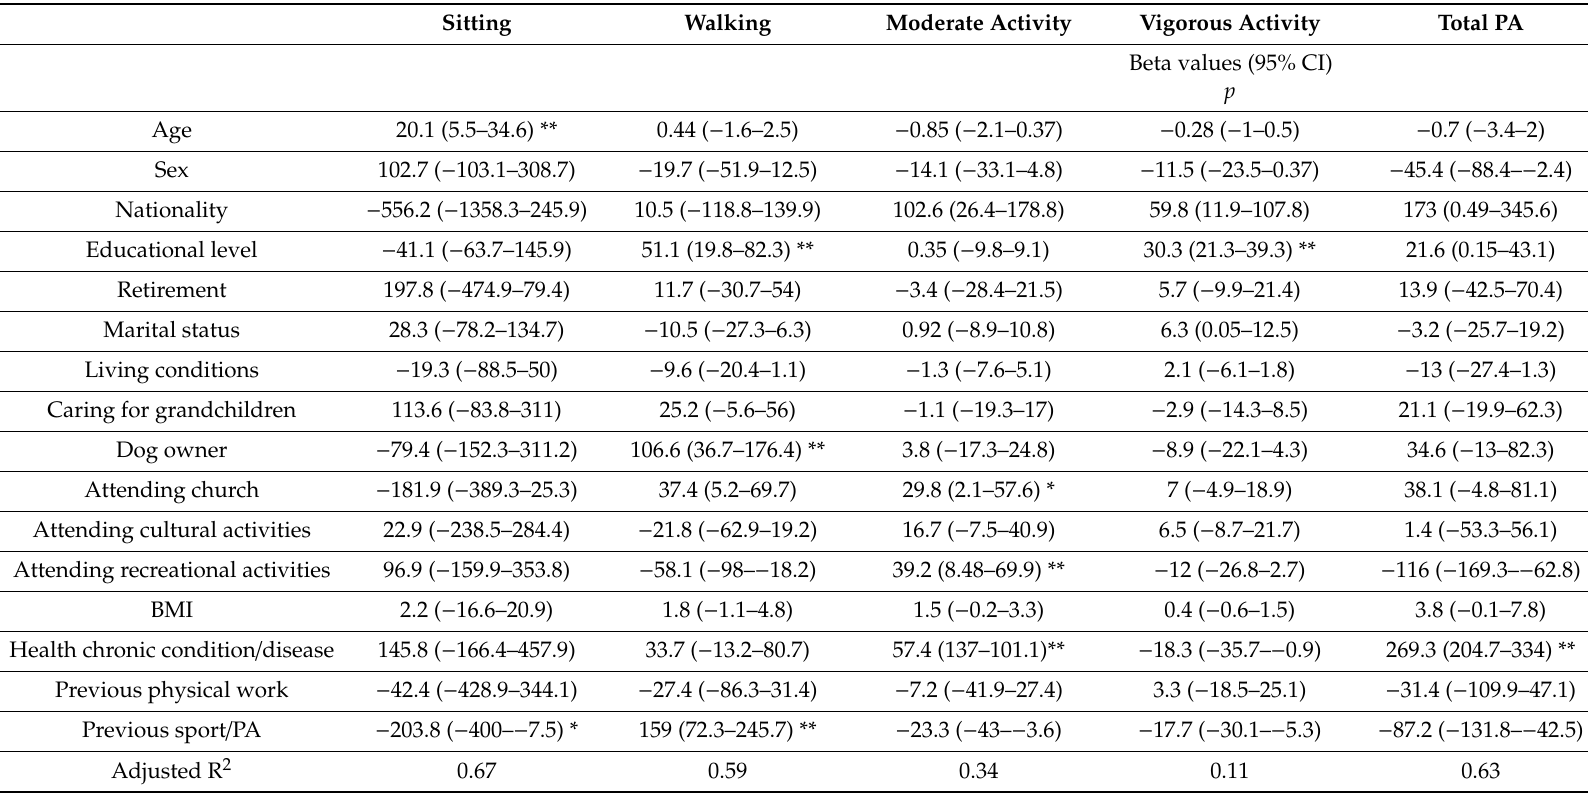
Table 3. Linear regression models with the corresponding values of adjusted R 2 for variables related to PA and inactivity reported by